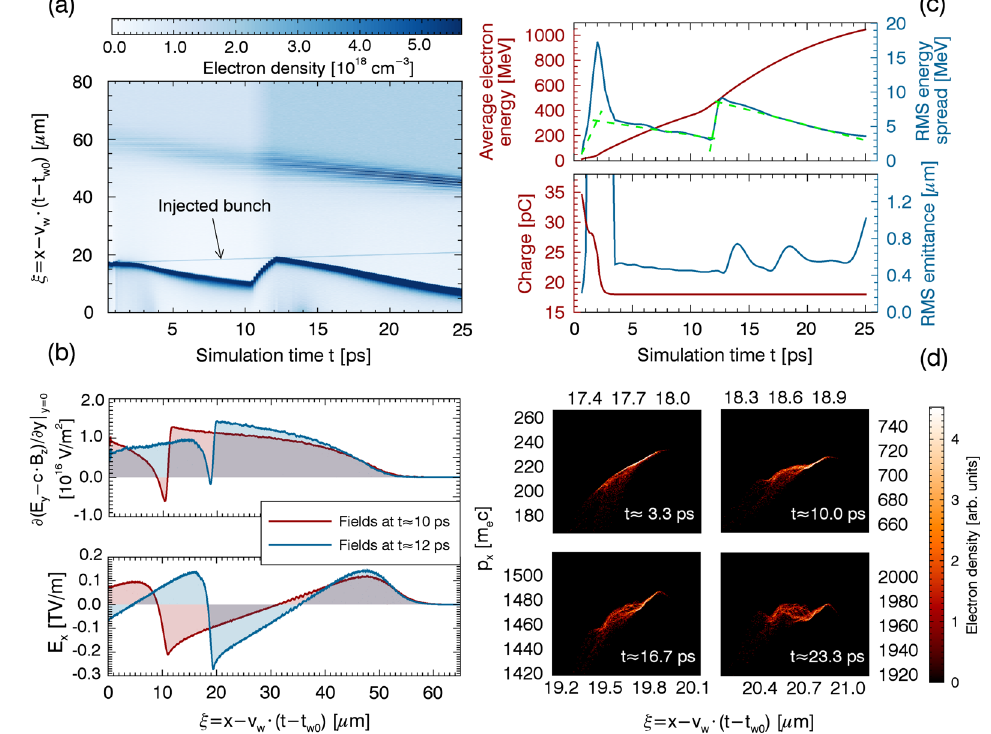
FIG. 4. 2D PIC simulation results of rephasing induced multiple momentum decompression and compression. (a) Evolution of on-axis electron density. (b) The profiles of transverse gradients of focusing fields and longitudinal acceleration fields before and after rephasing. (c) Evolution of electron average energy, rms energy spread, charge and rms emittance. The green dashed lines are the theoretical curves of Eq. (2), where k is obtained from (b) and Δ x 0 is obtained from (d). (d) Electron longitudinal phase space at different E